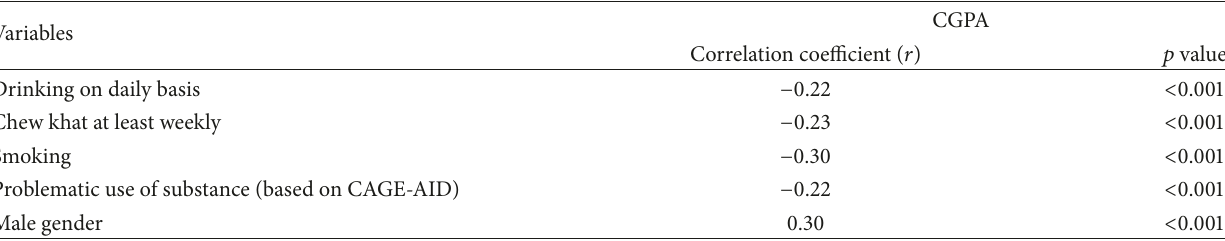
Table 4: Correlation of CGPA and selected variables among Wolaita Sodo University students,